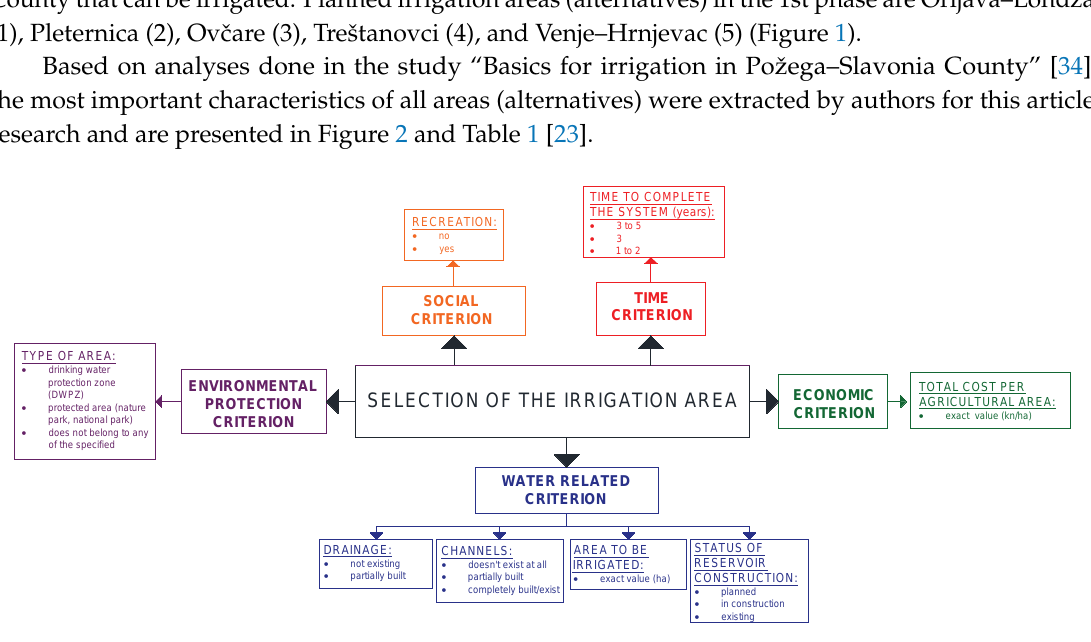
Figure 2. Selected criteria for MCA (Multi-Criteria Analysis).